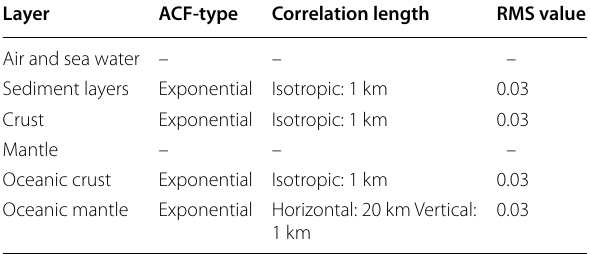
Table 1 Parameters of small-scale velocity fluctuations in each